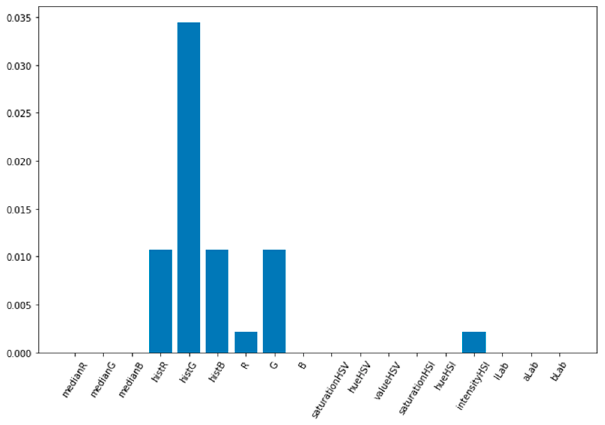
Figure 13. Feature importance graph for the Ensemble model generated by AutoML for salmon meat freshness classification.